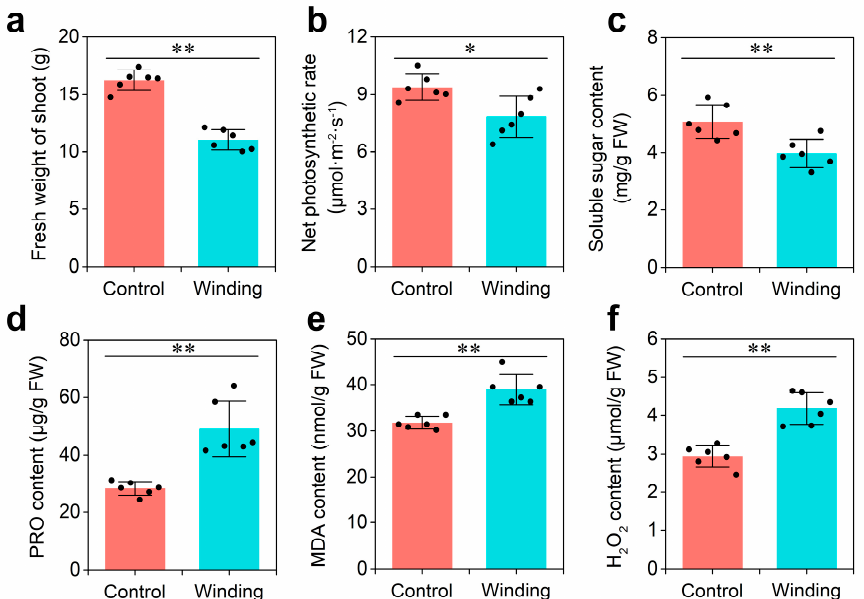
Figure 1. Physiological analysis of soybean in response to dodder parasitism: ( a ) Fresh weight of shoot; ( b ) net photosynthetic rate; ( c ) soluble sugar content; ( d ) proline (PRO) content; ( e ) malondi- aldehyde (MDA) content; and ( f ) H 2 O 2 content. Asterisks indicate significant differences between control (soybean without dodder) and winding (soybean winded by dodder) groups, determined by Student’s t -test ( n = 6; *, p < 0.05; **, p < 0.01). Error bars are ±SE.